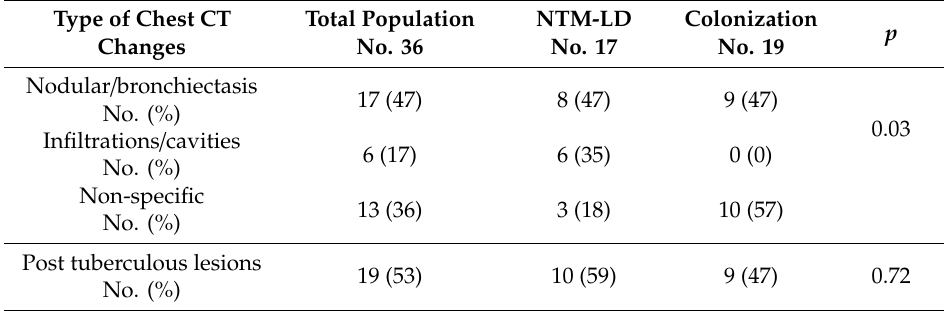
Table 2. Results of chest CT examination in 36 patients with obstructive lung diseases and with positive NTM respiratory